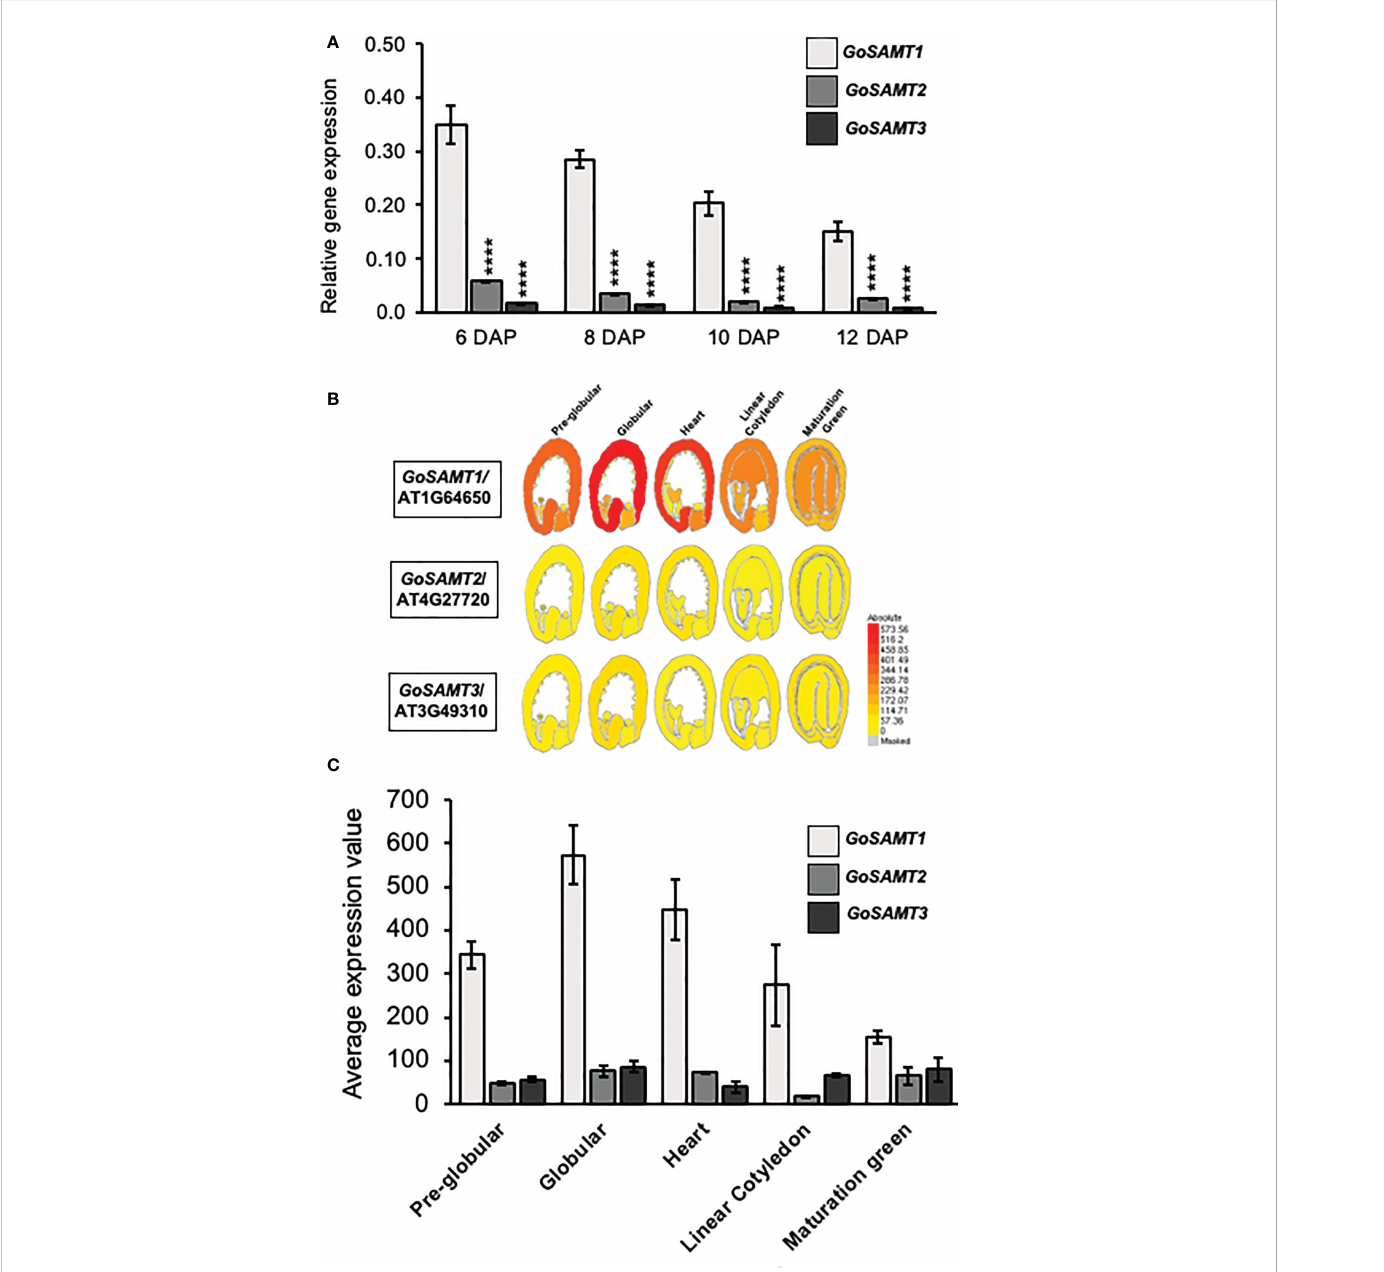
FIGURE 1 GoSAMTS expression pattern in Arabidopsis thaliana developing seed. (A) qRT-PCR analysis for steady-state levels of GoSAMTS gene transcript in developing seeds from 6 to 12 DAP in WT Col-0. Expression was calculated relative to EFIa44 and an At4g12590 seed-speci fi c reference gene . Error bars represent SE values from three biological replicates ( n = 9). Asterisks indicate signi fi cant statistical differences using Unpaired t-test with ****p<0.0001 comparing GoSAMT1 against GoSAMT2 and GoSAMT3 in each stage. (B) GoSAMT family member expression patterns during seed development; data obtained from eFP browser (http://bar.utoronto.ca/efp_arabidopsis/cgi-bin/efpWeb.cgi) (Winter et al., 2007). (C) Average seed coat expression values of GoSAMT family members in different seed-developmental stages; data obtained from eFP